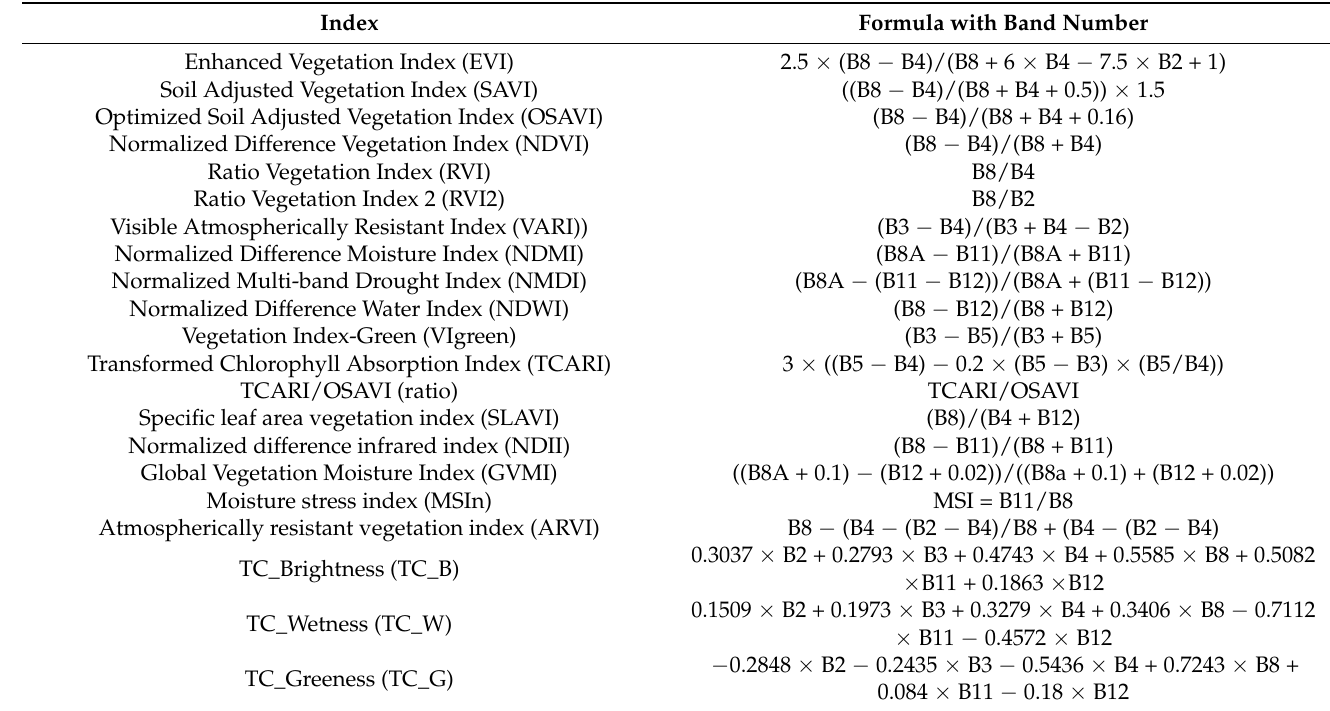
Table 2. Spectral indices derived from Sentinel-2 data. B stands for Sentinel-2